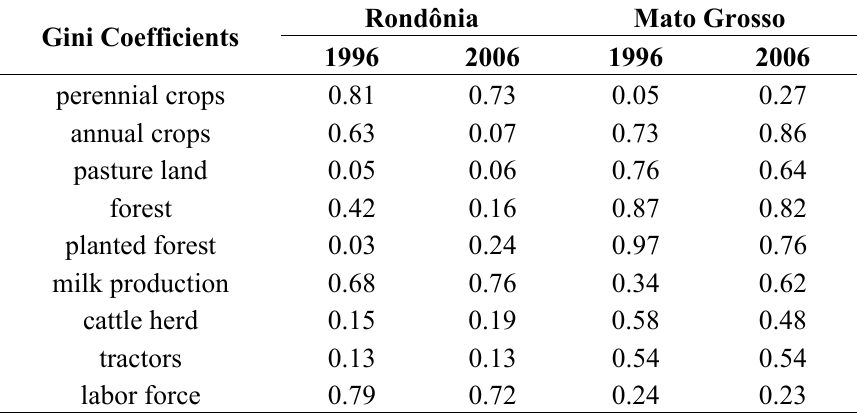
Table 4. Gini coefficients of land distribution per land use type, milk production, cattle herd and labor force using five categories of farm